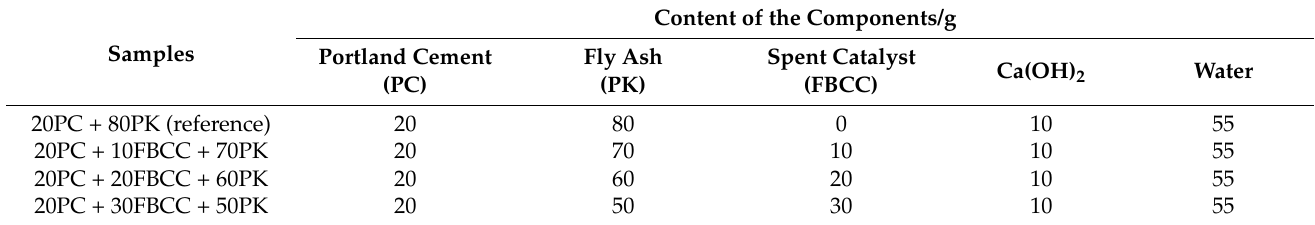
Table 1. Compositions of investigated